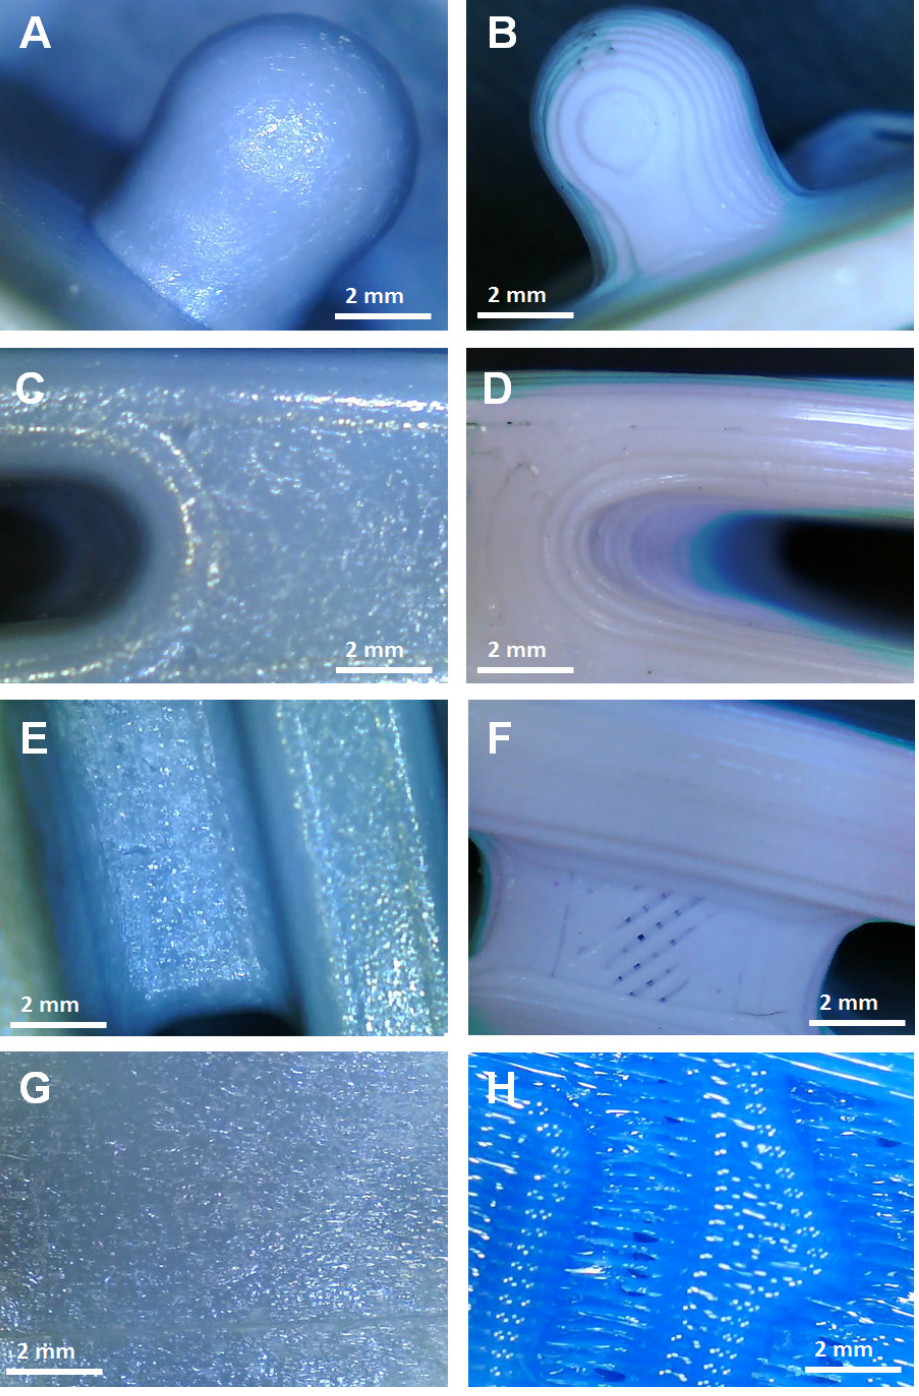
Figure 5. Comparison of manufacturing precision for traditional injection molding technology ( A , C , E , G ) and the incremental FFF technique ( B , D , F , H ).